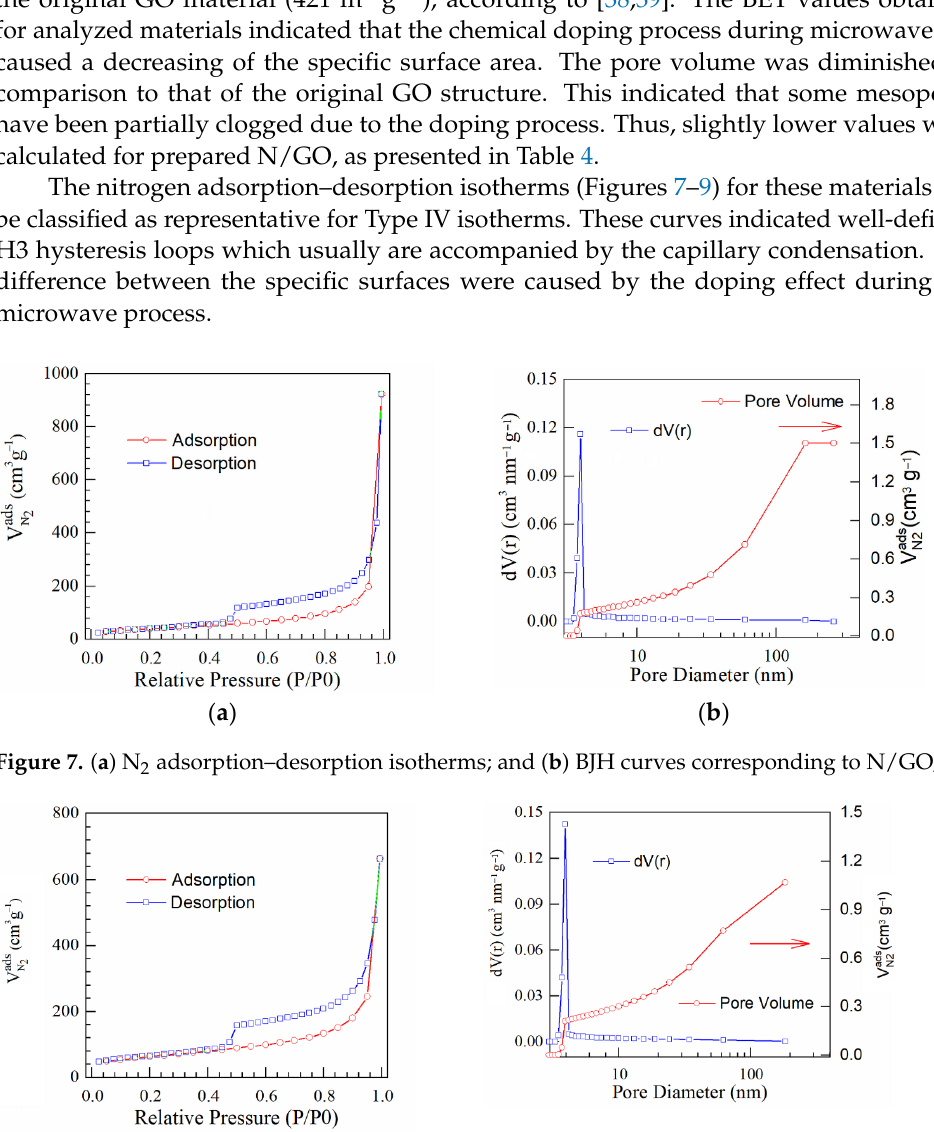
( b ) Figure 9. ( a ) N 2 adsorption–desorption isotherms and ( b ) BJH curves corresponding to N/GO_N. The difference noted for the calculated specific surface area (S BET ) could be correlated with nitrogen content of each sample. Thus, the S BET for N/GO_A and N/GO_N was estimated at 67 m 2 g −1 and 117 m 2 g −1 , respectively, while the nitrogen content was 7.42 wt.% and 2.44 wt.% These results indicated that the lowest S BET corresponds to the highest nitrogen content, possibly due to the obtaining of a chemically more doped graphene oxide during the microwave reaction. It was found that the lowest specific surface area corresponds to the GO doped in the presence of ammonia. The hysteresis type indicates the presence of the micro and mesoporous structure in the N/GOs layers with plate-like slit-shaped pores. The pore size distribution calculated by BJH method considering the desorption branch displays a unimodal peak centered at 7 nm. The BJH pore-size distribution method pointed out the dominant role of mesoporosity, which contributed to approx. 65.8% of the total pore volume, while the microporosity contributed to approx. 33.2%. The remaining approx. 1% of the total pore volume was caused by macroporosity. Thermogravimetric analysis (TGA) was employed to investigate the thermal stability of the prepared nanocomposites. The synthesized nitrogen-doped graphene exhibited similar curves with good thermal stability. TGA weight loss curves of prepared samples are presented in Figure 10. It was observed that the obtained thermograms show different temperature ranges for the thermal decomposition: an important mass loss in the decomposition range of 150–300 °C, emphasizing the efficient removal of oxygen functional groups during the chemical process in the microwave field; a continuous mass loss from 300–600 °C, possibly due to the loss of sp 2 carbon atoms in a hexagonal structure that occurs between the decomposition temperatures of 320 and 650 °C [40], which is associated with the elimination of certain functionalities specified by FTIR analysis. It is important to note that the drop in the 20–150 °C domain, especially for the sample N/GO_A is certainly due to the high nitrogen content, and is consistent with the